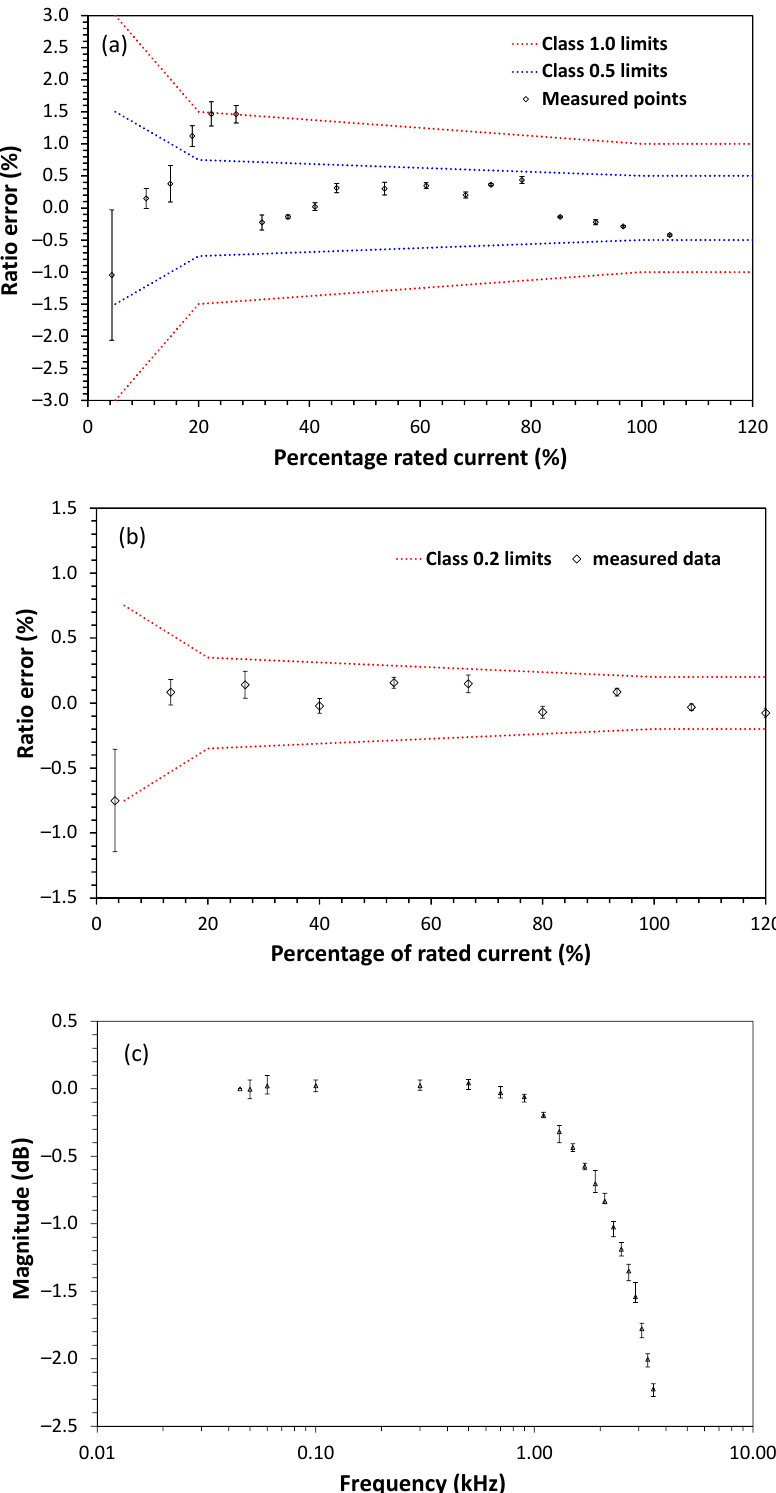
Figure 8. Current sensor characterization: ( a ) ratio error for 1.25–30 A range for the rated current of 25 A, ( b ) ratio error for 37.5–900 A range for the rated current of 750 A and ( c ) bandwidth.